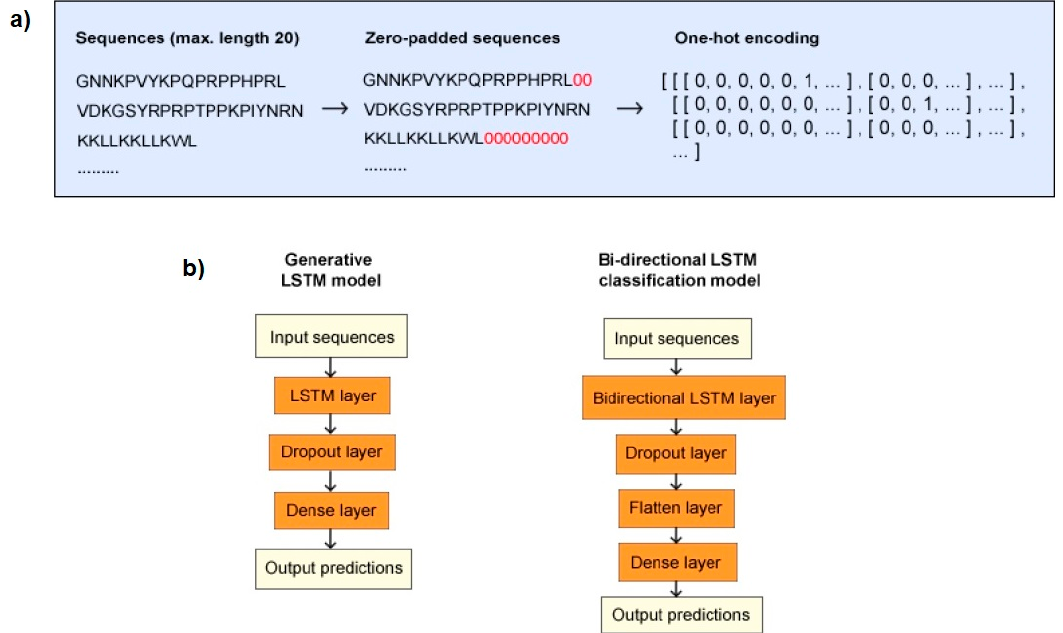
Figure 2. Data processing ( a ) and model structures ( b ). ( a ) Sequences had a maximum length of 20 residues and were zero-padded if their length was under 20 residues. Subsequently, the sequences were one-hot encoded, after which they were ready to be input into the deep learning models. ( b ) The generative long short-term memory (LSTM) model started with an LSTM input layer. A dropout layer was added to reduce overfitting and a dense layer was the last layer, responsible for outputting probabilities. The bidirectional LSTM classification model started with a bidirectional LSTM input layer, after which a dropout layer was applied. A flatten layer was added to reduce the dimensions of the input data, and a dense layer was responsible for the output of predictions.